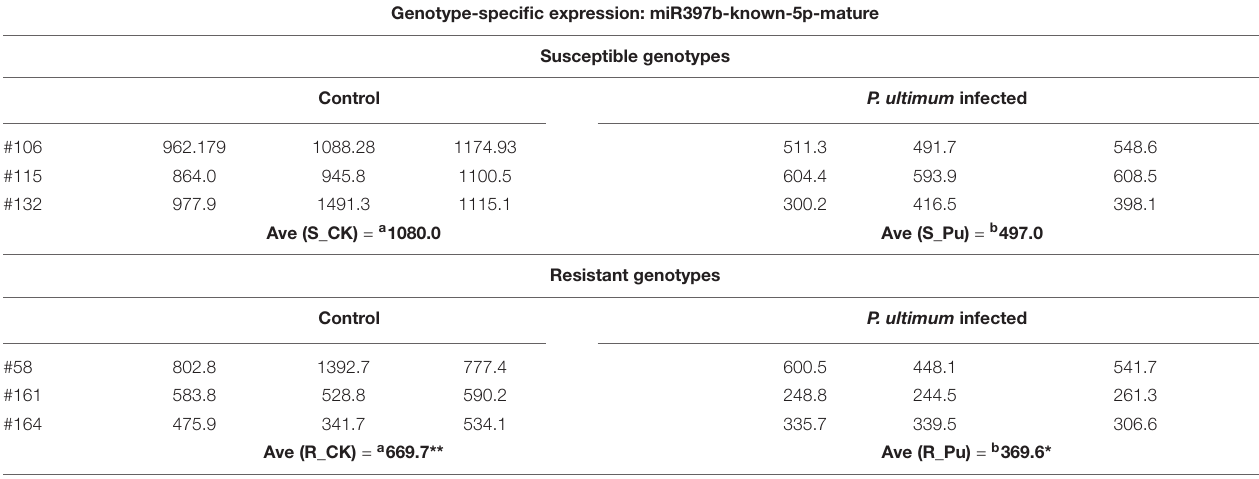
TABLE 5 | The genotype-specific expression of miR397b and target genes in response to Pythium ultimum infection of apple roots. Genotype-specific expression: